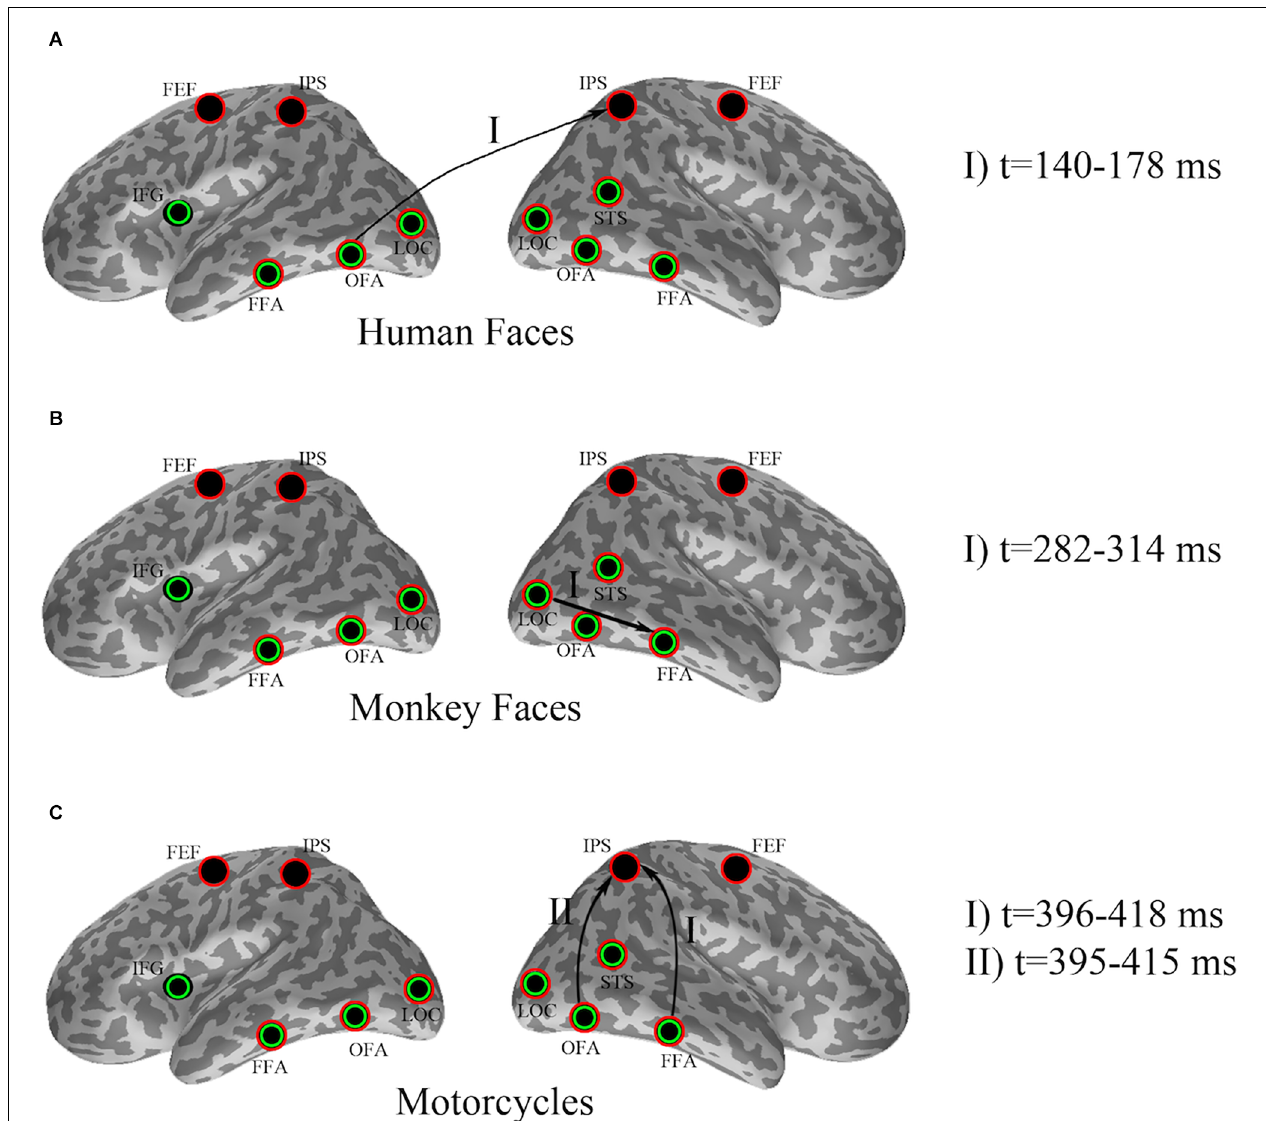
FIGURE 2 | Effect of pre-stimulus alpha power on evoked responses for (A) human faces, (B) monkey faces, and (C) motorcycles. Seed ROIs were marked with green circles, whereas red circles specified the target ROIs. Arrows indicate significant effects, where pre-stimulus alpha-power in a seed region (beginning node in each directional connection) modulates the evoked response in a target region (ending node of that connection). The time intervals at which the significant dissociations were recognized by cluster-based permutation have been added as the